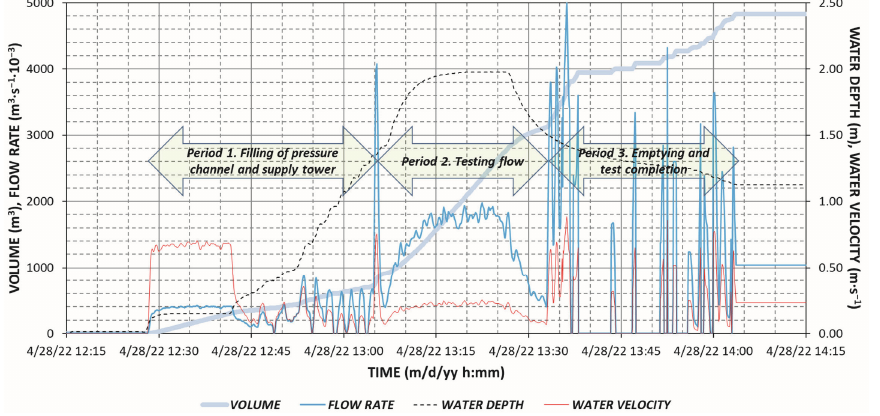
Figure 13. Test Session 1: Inflow hydrograph, water volume, water depth, and flow velocity recorded by the flowmeter in the auxiliary channel.